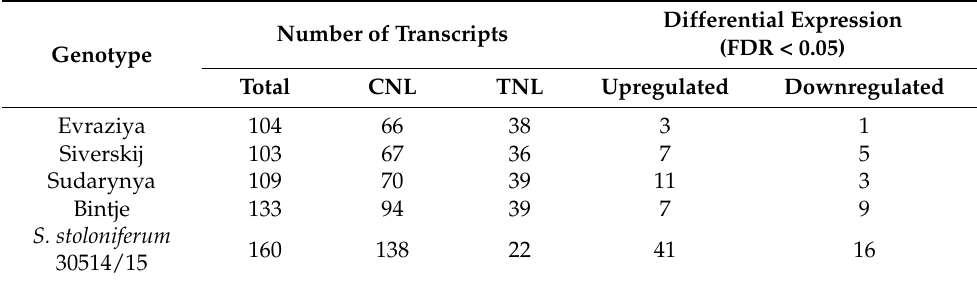
Table 3. Novel NBS-LRR sequences in five potato